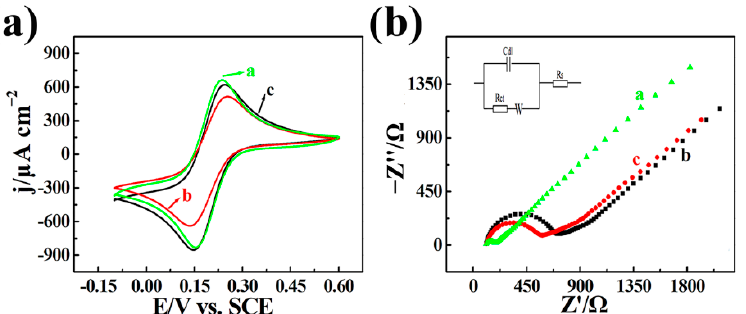
Figure 3. ( a ) CVs and ( b ) EIS (inset: equivalent circuit diagram) of GCE (curve a, green line), COF TFPB-NBPDA /GCE (curve b, red line), and AuNPs@COF TFPB-NBPDA /GCE (curve c, black line) in 0.1 M KCl solution containing 5 mM Fe[(CN) 6 ] 3 − /4 − probe.